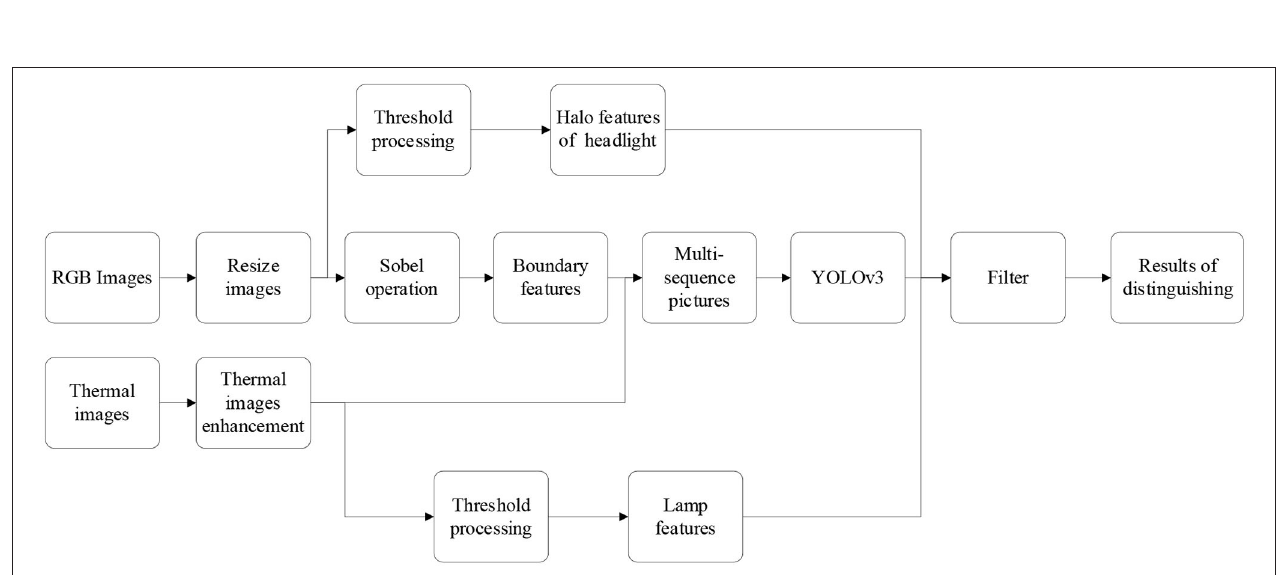
FIGURE 10 | Diagram of the dynamic change process of high beam headlights from far to near.